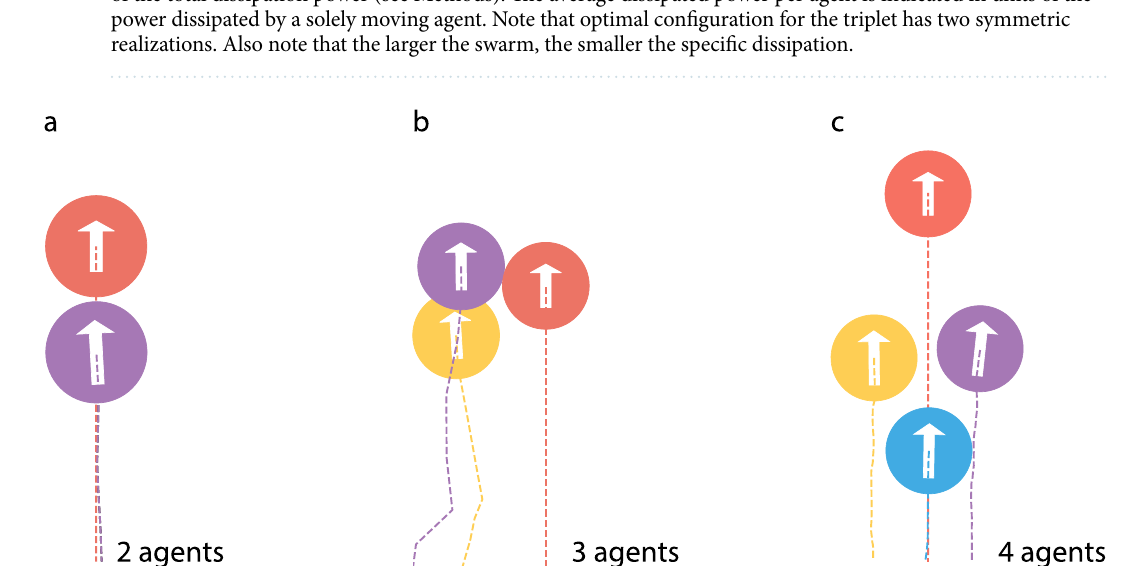
Figure 5. Optimal conformation for the group locomotion, obtained by RL for a system of two ( a ), three ( b ) and four agents ( c ). The red circle depicts the leader comfort zone, and circles of other color show the agent-followers comfort zones. The lines represent trajectories. Note that the configurations found by the RL practically coincides with those, obtained by a direct optimization, Fig.